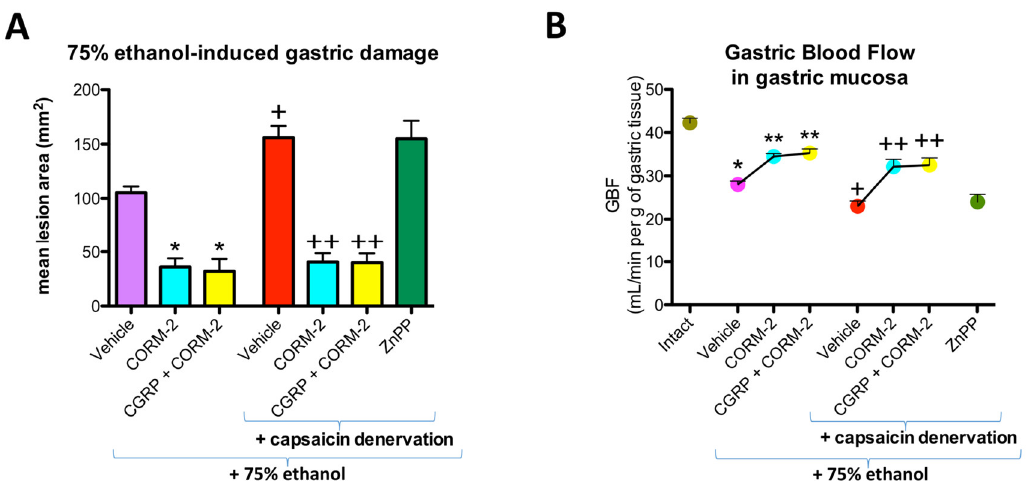
Figure 1. Mean area of 75% ethanol-induced gastric damage ( A ) and gastric blood flow (GBF) ( B ) in rats with or without afferent sensory neurons ablation (capsaicin denervation) and pretreated with vehicle, CORM-2 (5 mg/kg i.g.), ZnPP (5 mg/kg i.g.) alone or in combination with CGRP- α (10 µ g/kg i.p.). Intact refers to healthy gastric mucosa, not exposed to 75% ethanol. Results are mean ± SEM of 4–5 rats per each experimental group. ( A ) Significant change as compared with the respective values in vehicle-control group without capsaicin denervation was indicated by asterisk or cross ( p < 0.05); double crosses indicate significant changes compared to the values obtained in the vehicle-pretreated group with capsaicin denervation ( p < 0.05); ( B ) Significant change as compared with the respective values in intact gastric mucosa was indicated by asterisk ( p < 0.05); double asterisks indicate significant changes compared to the values obtained in the vehicle-pretreated group without capsaicin denervation ( p < 0.05); cross indicates a significant change as compared with the respective vehicle-pretreated and capsaicin-denervated animals ( p < 0.05); double crosses indicate significant changes compared to the values obtained in the vehicle-pretreated group with capsaicin denervation ( p < 0.05).